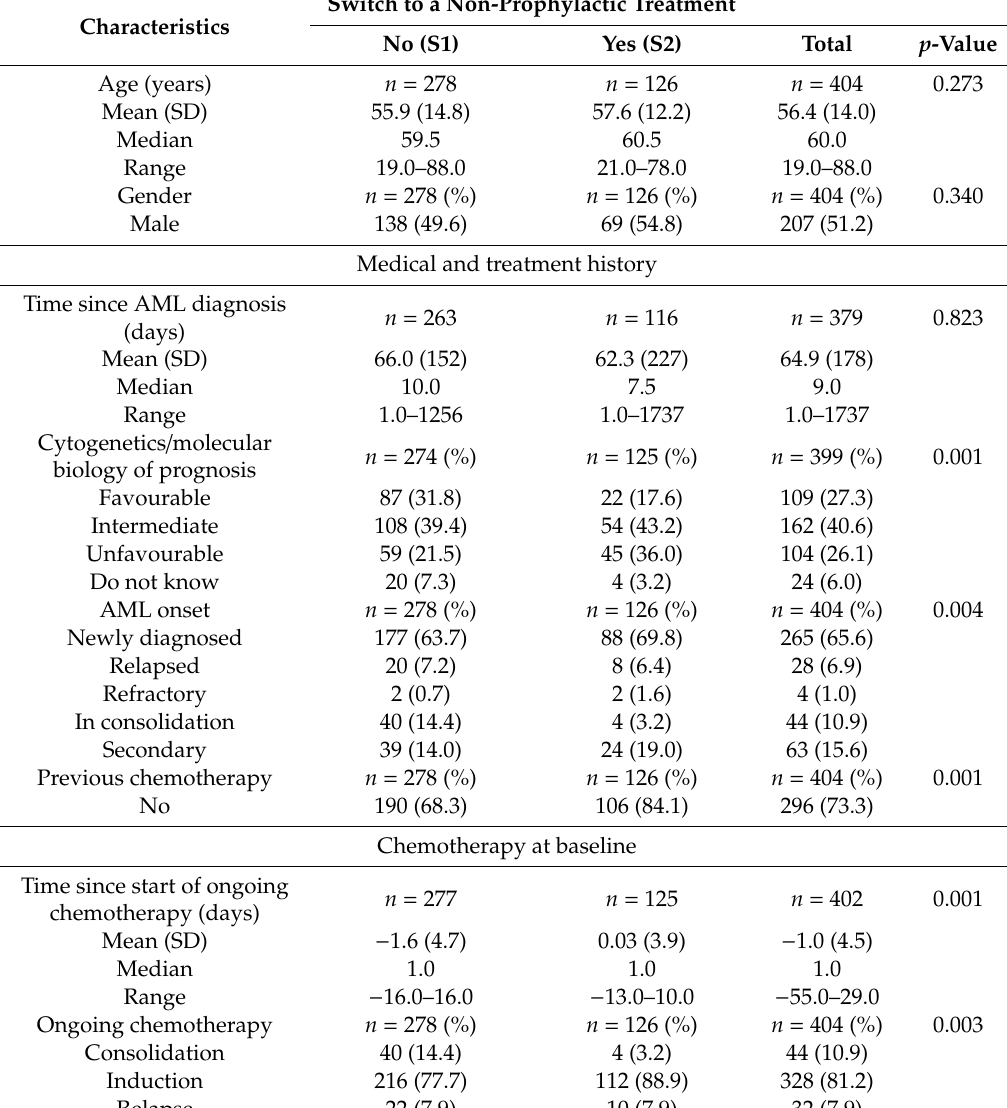
Table 1. Baseline characteristics.